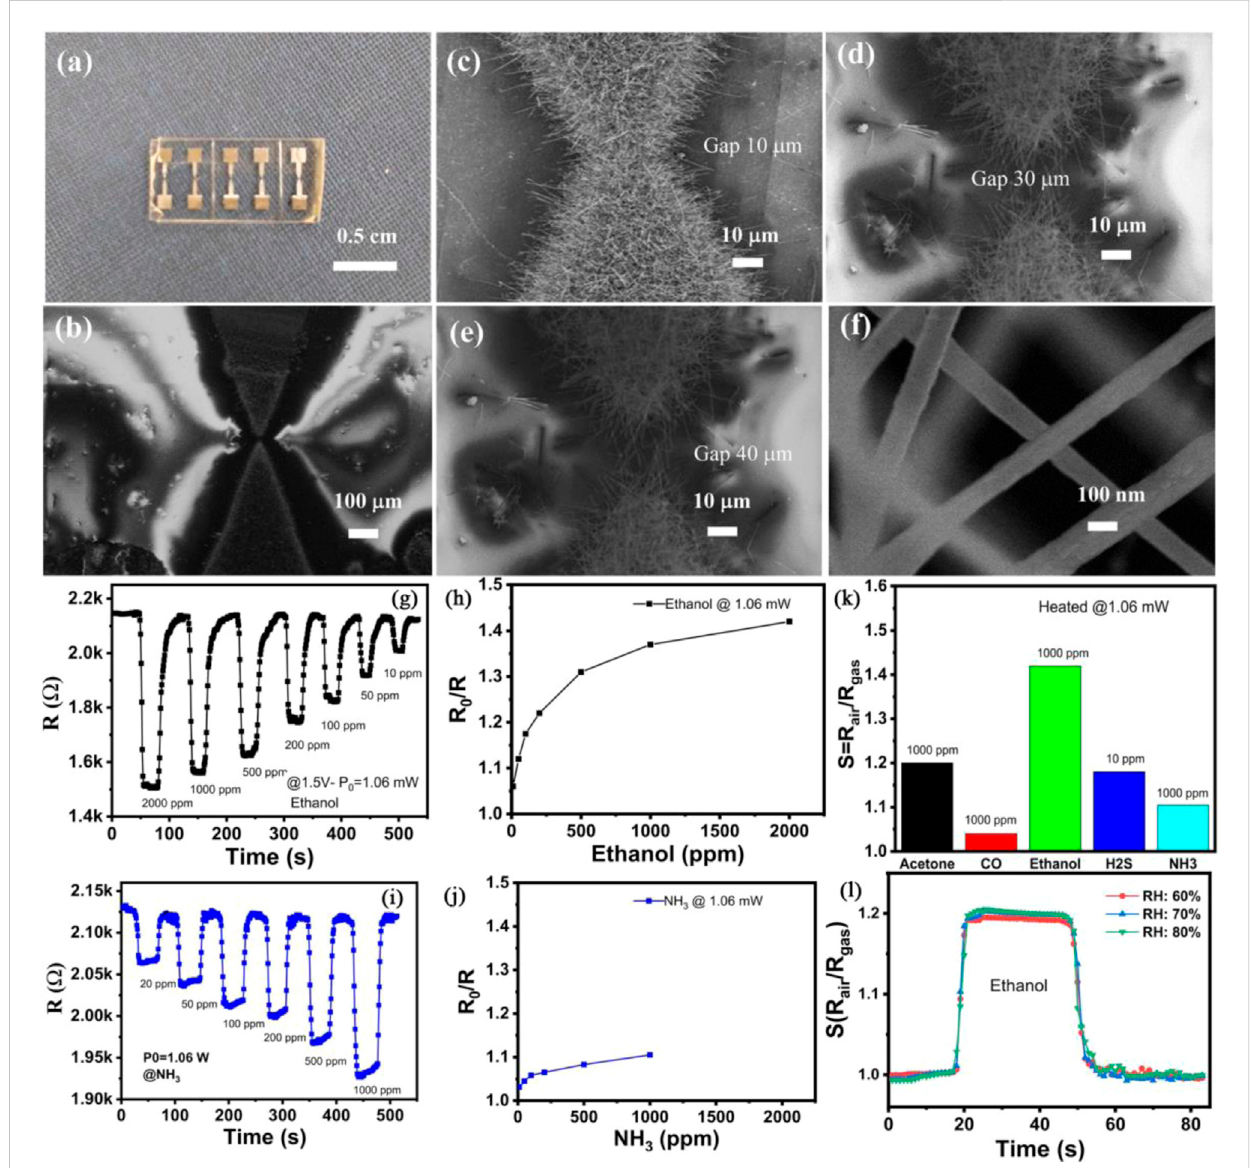
FIGURE 1 (A) Digitalimageoftheassembledgassensor. (B) SEMimageofagassensor. (C – E) SEMimageofIn 2 O 3 nanowiresgrownatelectrodeswithgaspsof 10, 30 and 40 μ m, respectively. (F) High magni fi cation SEM of In 2 O 3 nanowires. (G, H) Dynamic gas sensing performance and sensor response (I, J) of sensor-40 to 10 – 2000 ppm ethanol or NH 3 at room temperature. (K) Selective gas sensing performance of sensor-40. (L) ethanol gas sensing behavior of sensor-40 under different humidity. Reprinted with permission from ref. (Son et al., 2022). Copyright 2022,